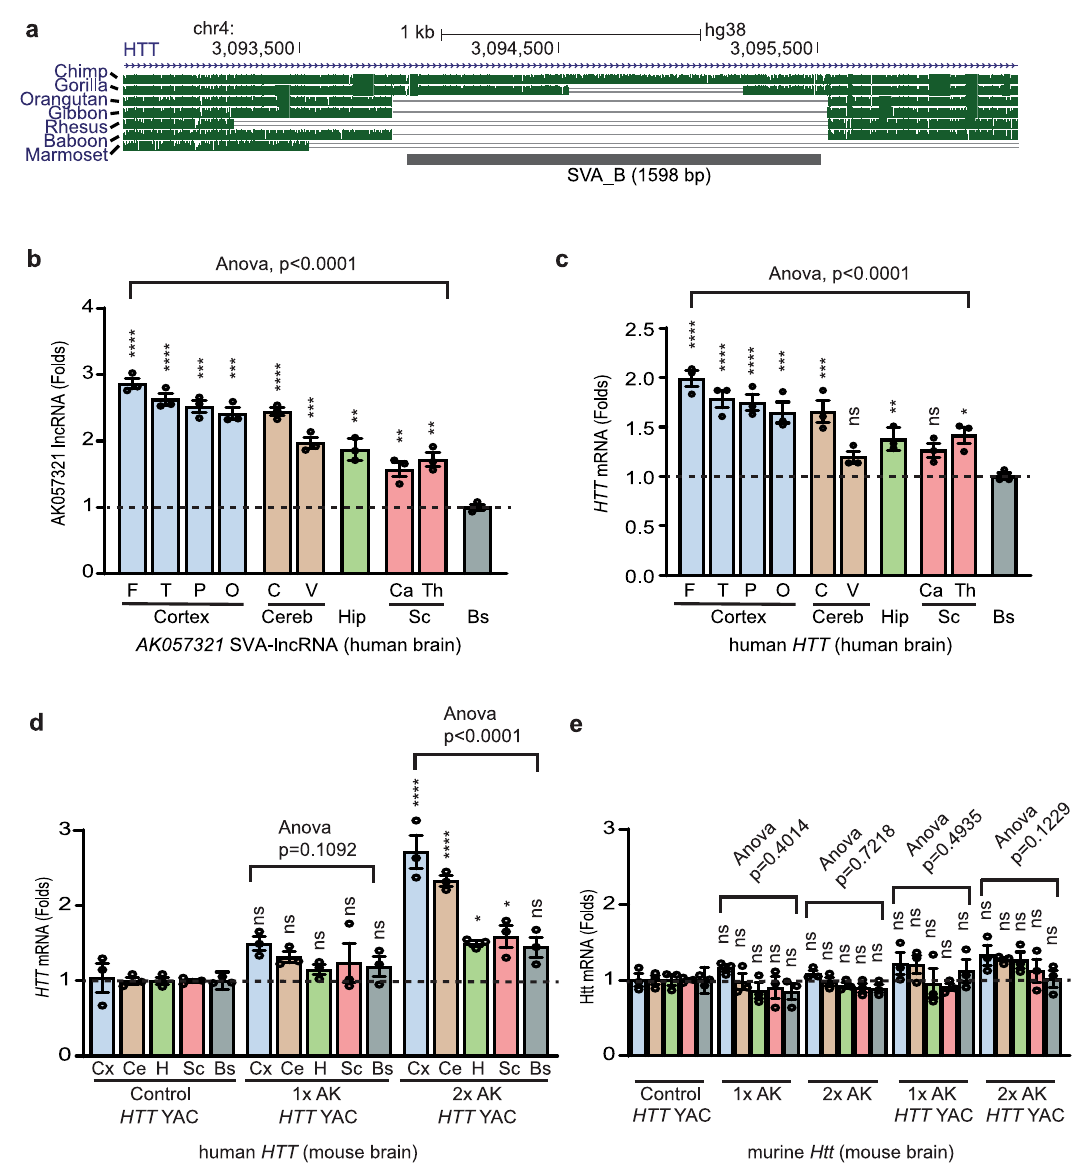
Fig. 5 SVA-lncRNA AK057321 reconstitutes human-speci fi c cerebral cortex and cerebellum-enriched expression of human HTT gene in transgenic mice. a Illustration of SVA_B retrotransposon located within the HTT gene, UCSC genome browser (GRCh38/gh38). b Native SVA-lncRNA AK057321 transcript levels differ across human brain regions compared to levels in Bs. One-way ANOVA ( F 9,20 = 43.19, versus control Bs). c HTT transcript analysis with quantitative RT-qPCR on human brain tissue shows HTT transcript expression varies across human brain regions, compared to levels in Bs. One-way ANOVA ( F 9,20 = 14.20, p < 0.0001) with Bonferroni tests. d HTT is increased more in the cortex and cerebellum compared to other brain regions in 2x AK057321/HTT mice. One-way ANOVA ( F 9,20 = 15.77, p < 0.0001) with Bonferroni tests. No difference is seen in 1x AK057321/HTT and HTT control mice. One-way ANOVA ( F 9,20 = 1.934, p = 0.1052) with Bonferroni tests. e Mouse Htt transcript across brain regions. One-way ANOVA with Bonferroni tests for 2x AK057321/HTT ( F 9,20 = 1.840, p = 0.1229); for 1x AK057321/HTT , ( F 9,20 = 0.9679, p = 0.4935); for 2x AK057321 ( F 9,20 = 0.6754, p = 0.7218); and for 1x AK057321 ( F 9,20 = 1.107, p = 0.4014). c – e RPL13A was used as the internal reference gene. For all experiments above, 6 mice per genotype were used. qRT-PCR performed on n = 3 RNA samples (each pooled from two mice). Data represent the mean ± SEM. **** p < 0.0001, *** p < 0.001, ** p < 0.01, * p < 0.05, ns p > 0.05. AK : AK057321 , F: frontal cortex, T: temporal cortex, P: parietal cortex, O: occipital cortex, Cx: cortex, V: vermis, H/Hip: